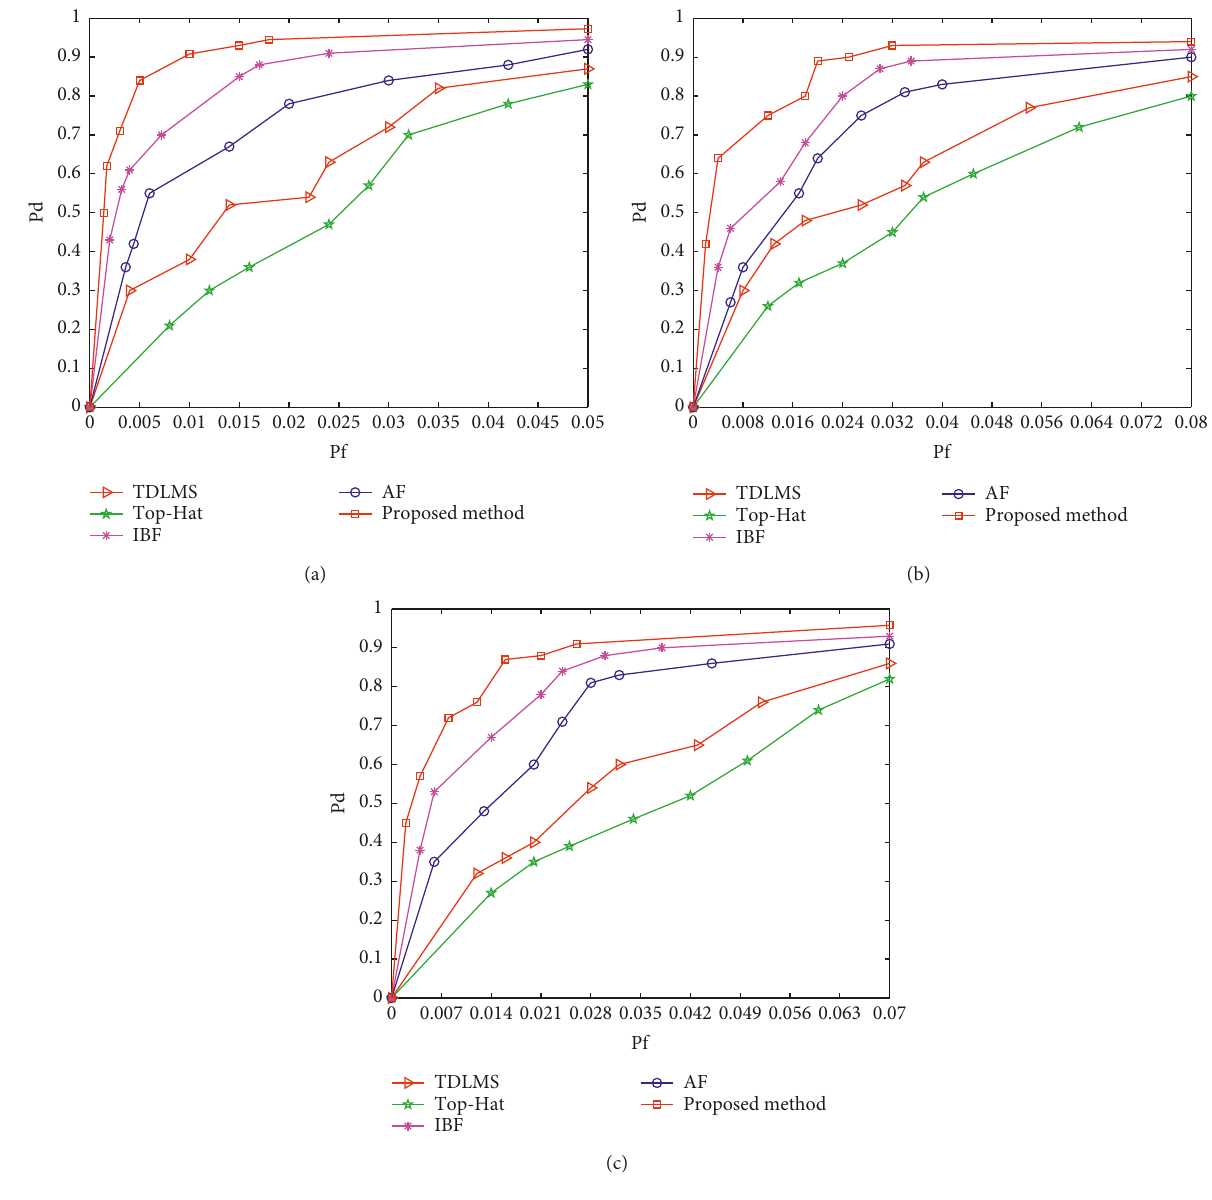
Figure 9: ROC curves of different